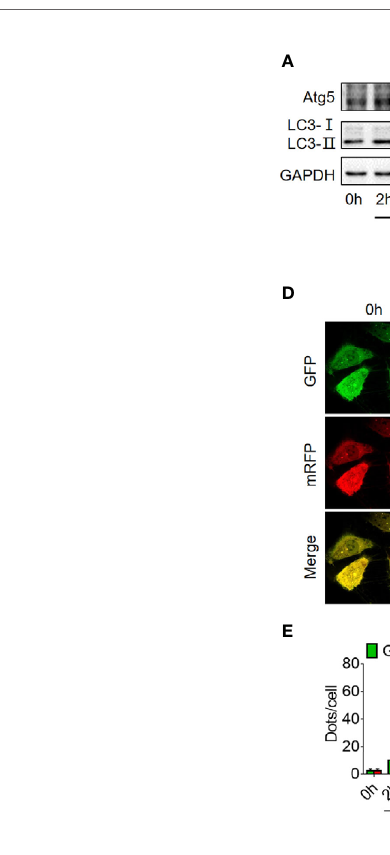
FIGURE 2 | Autophagy determination in LPS-induced HK-2 cells. (A) Representative western blot showing the Atg 5 and LC3II protein expression levels in HK-2 cells following LPS stimulation at various time-points. GAPDH was used as an internal reference. (B, C) densitometric analyses of Atg5 and LC3II protein expression. n = 4-5. (D) The autophagic fl ux in HK-2 cells was determined by cellular immunoassay following LPS stimulation at various time-points. The autophagy double- labeled adenovirus mRFP-GFP-LC3 was used to detect autophagic fl ux (magni fi cation ×630 and scale bar = 10 µm). (E) The mean number of GFP and mRFP dots per cell. (F) The mean numbers of autophagosomes and autolysosomes per cell. * p < 0.05, ** p < 0.01 vs. the 0 h group, ## p < 0.01 vs. the 8 h group. The results are representative of at least three independent experiments. LPS, lipopolysaccharide; Atg5, autophagy-related protein 5; LC3II, Microtubule-associated protein 1A/ 1B-light chain 3; GAPDH, glyceraldehyde 3-phosphate dehydrogenase; mRFP, monomeric red fl uorescence protein; GFP, Green fl uorescent